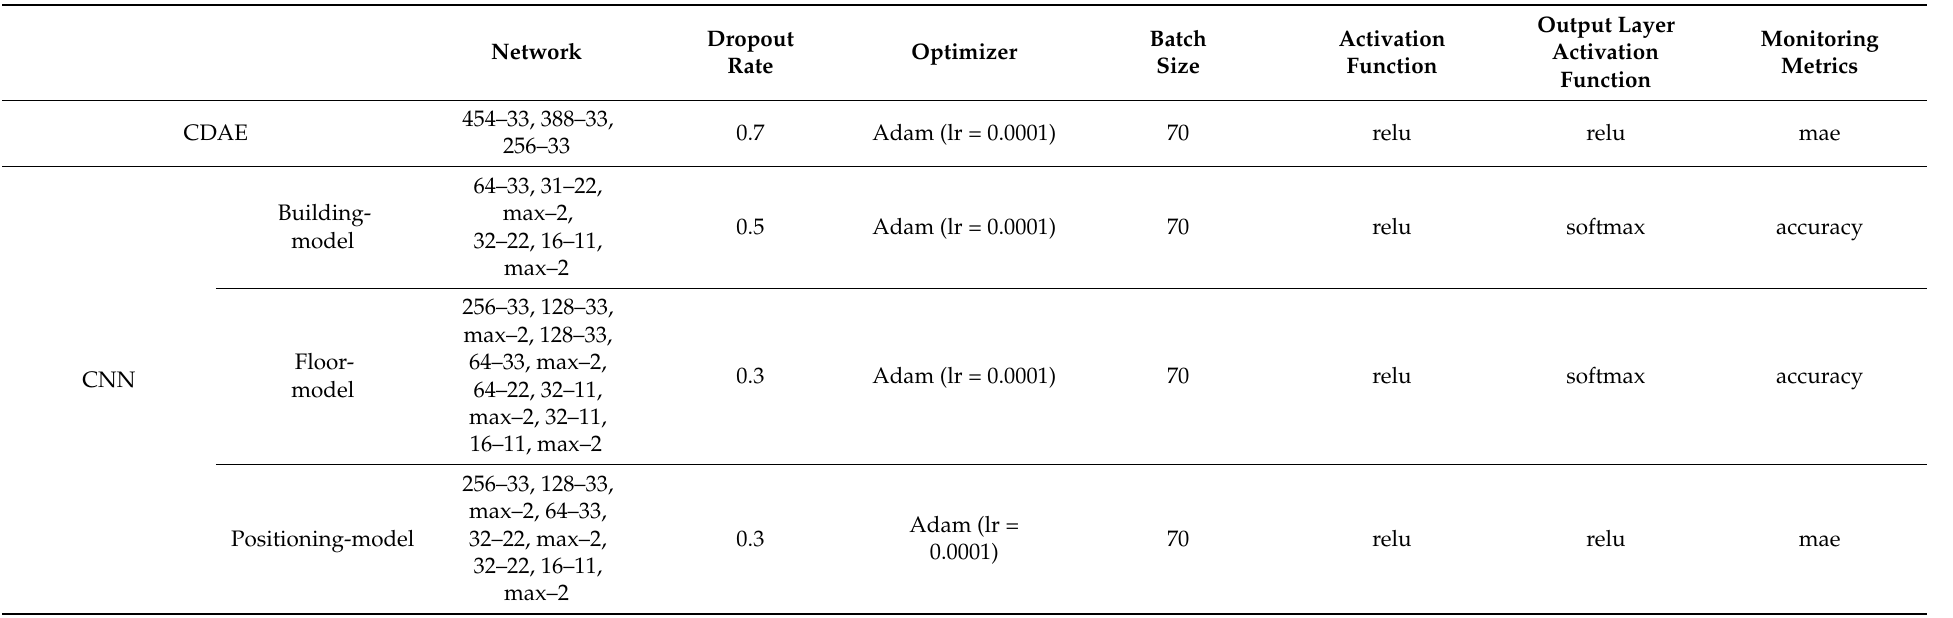
Table 8. Model parameters on the UJIIndoorLoc